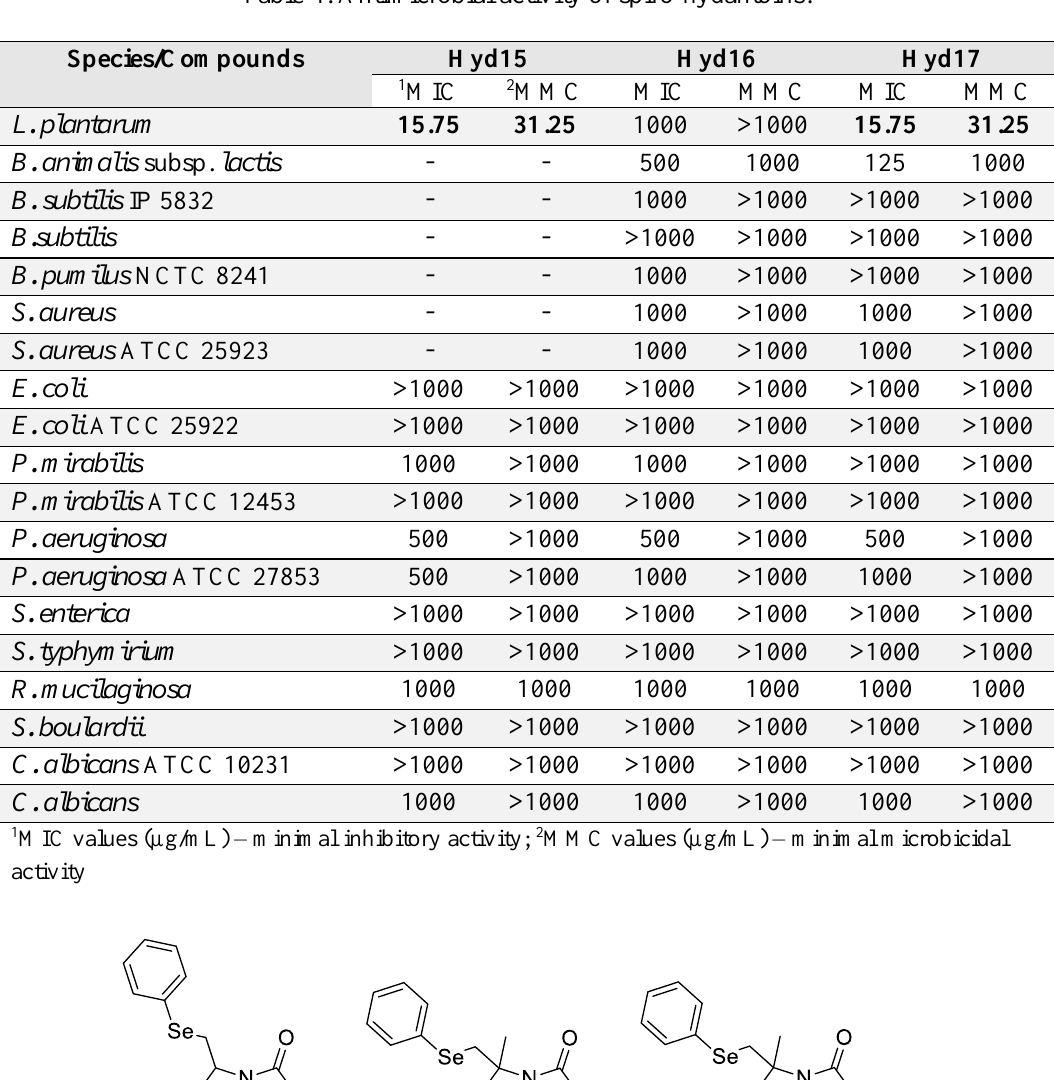
Table 4. Antimicrobial activity of spiro-hydantoins.